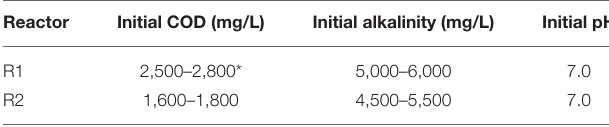
TABLE 1 | Characteristics of the feed for the reactors R1 and R2.